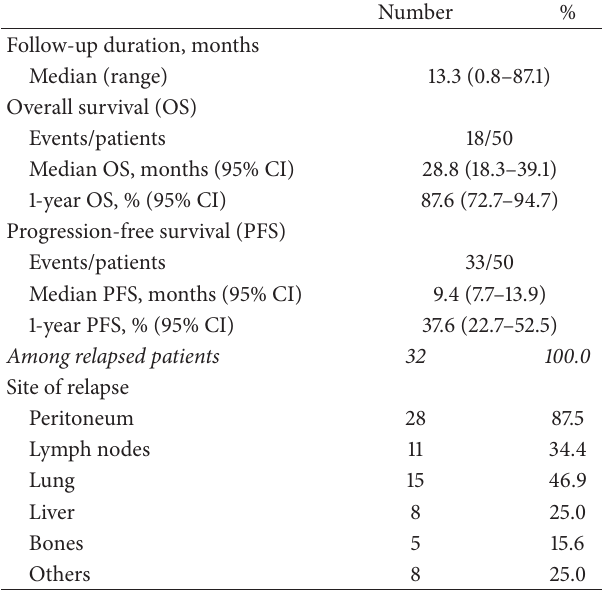
Table 2: Survival outcomes and